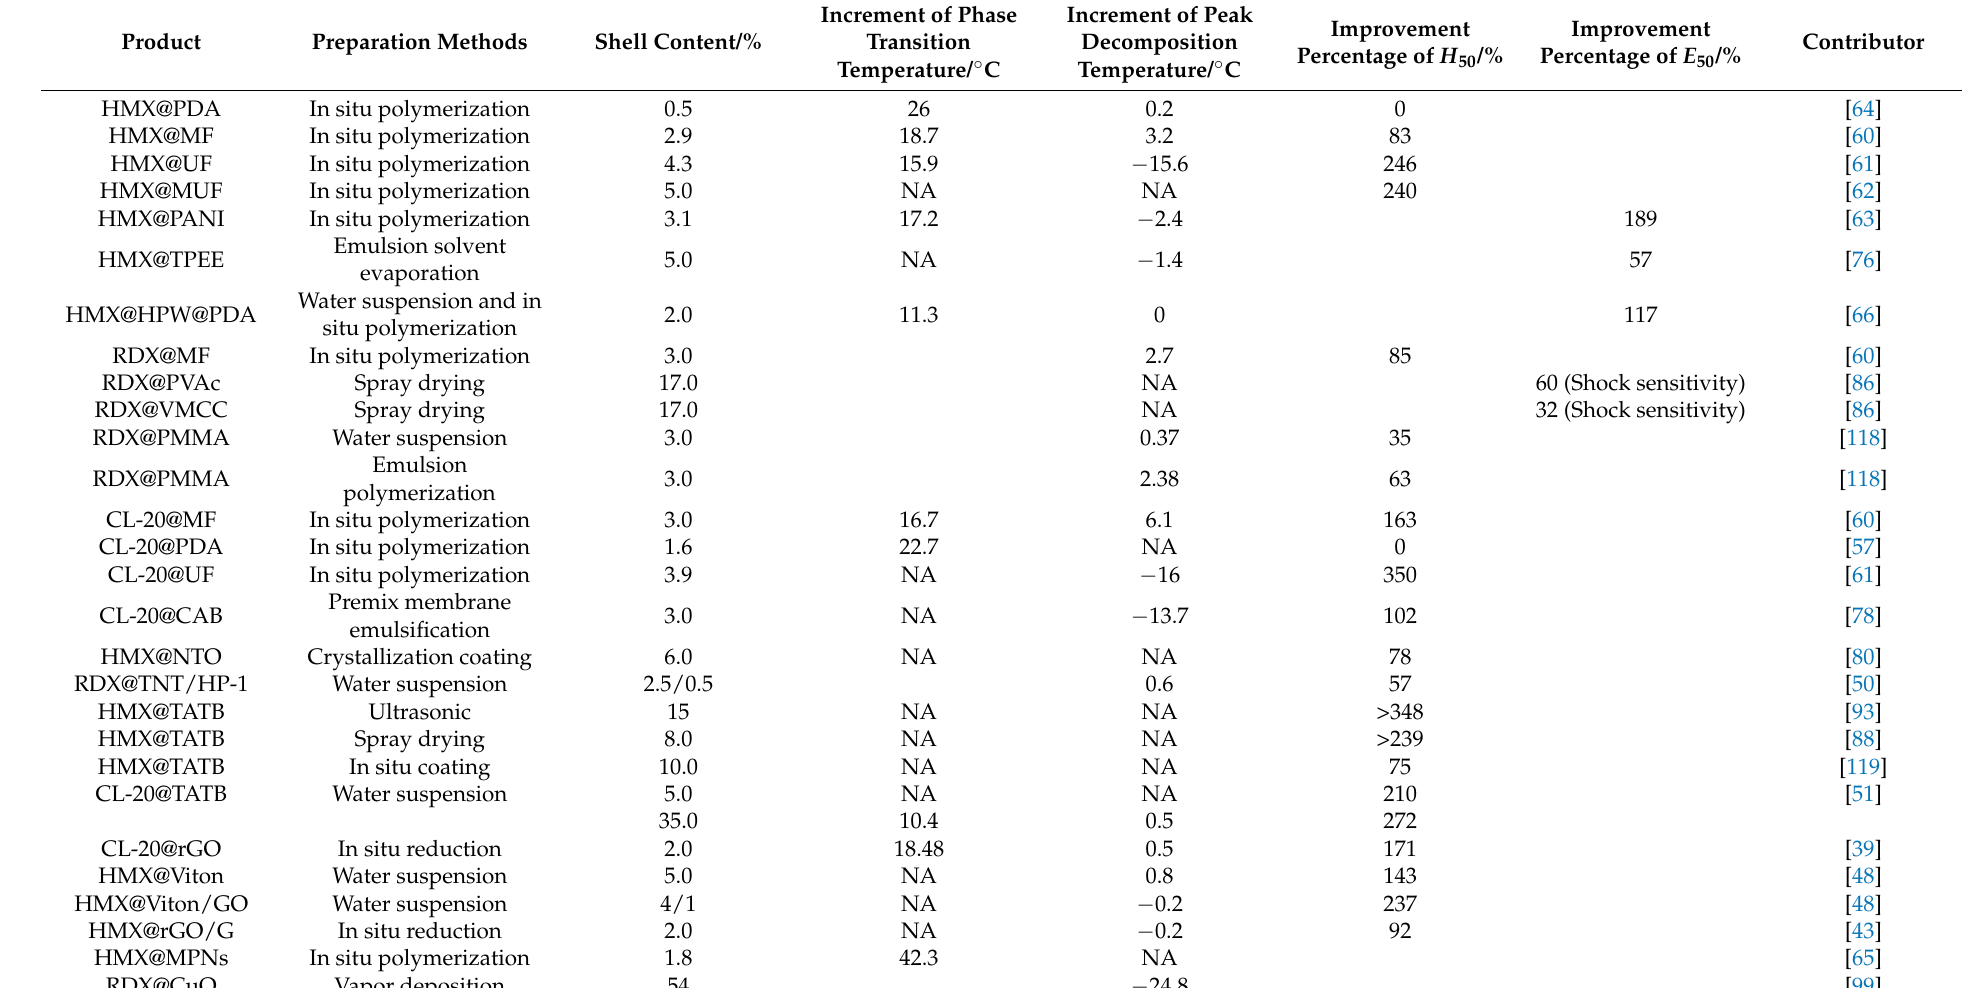
Table 3. Preparation methods and properties improvement of some